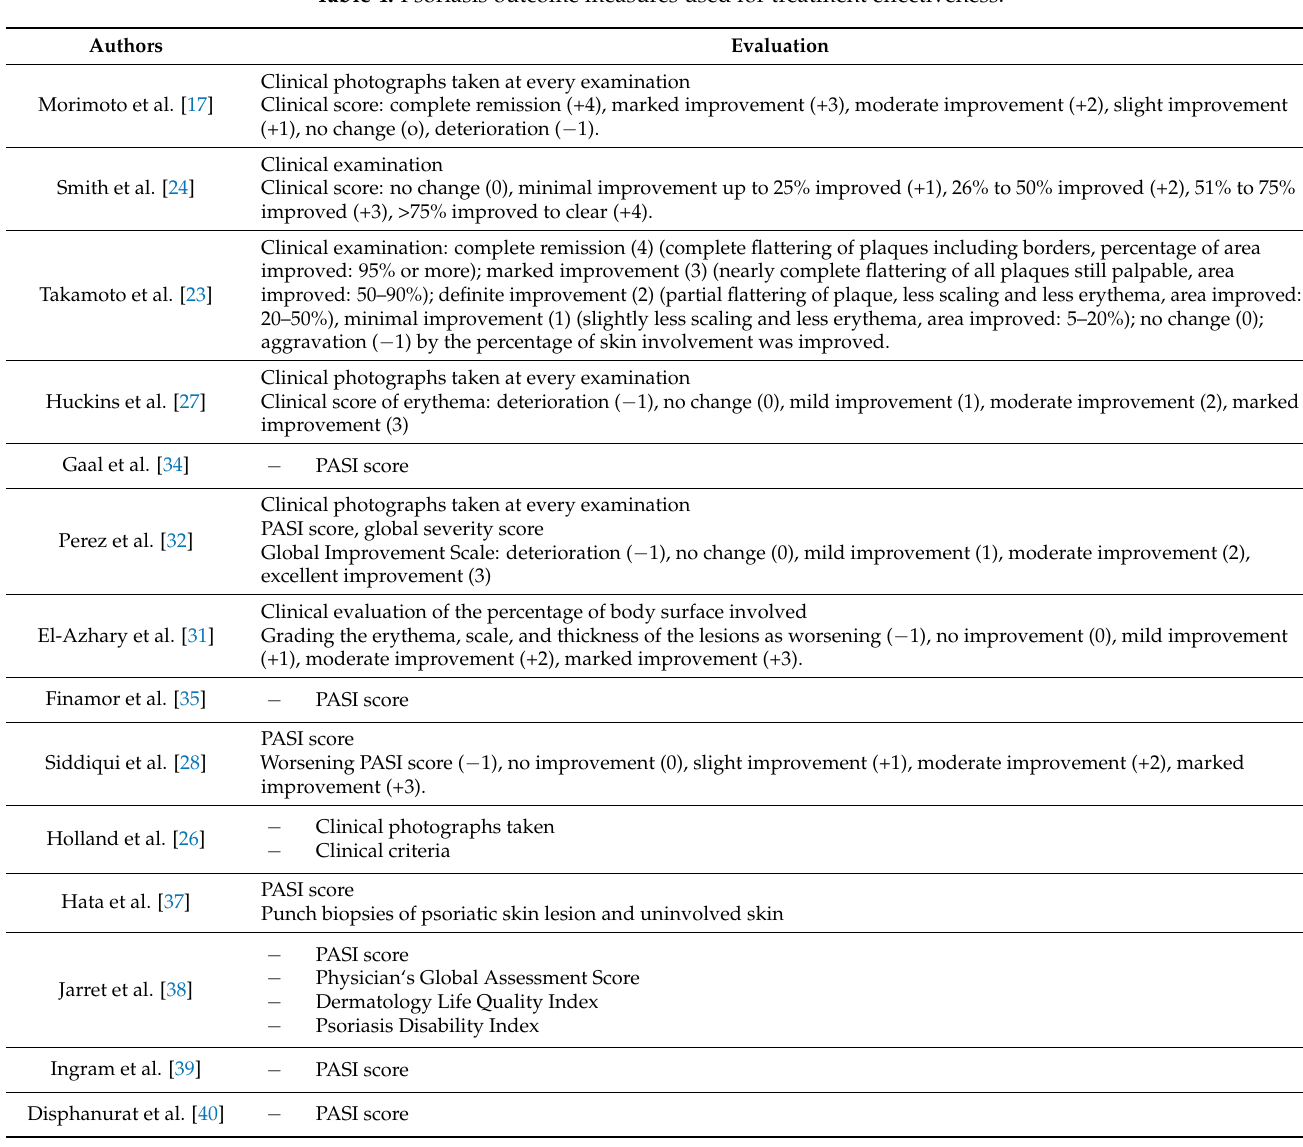
Table 4. Psoriasis outcome measures used for treatment